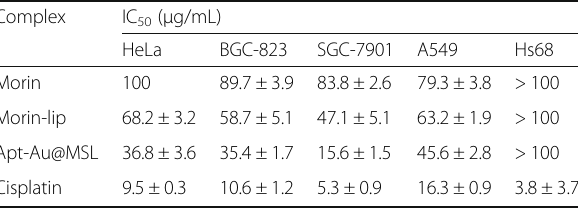
Table 1 IC 50 values of Morin, Morin – liposomes, and Apt- Au@MSL in various human cancer